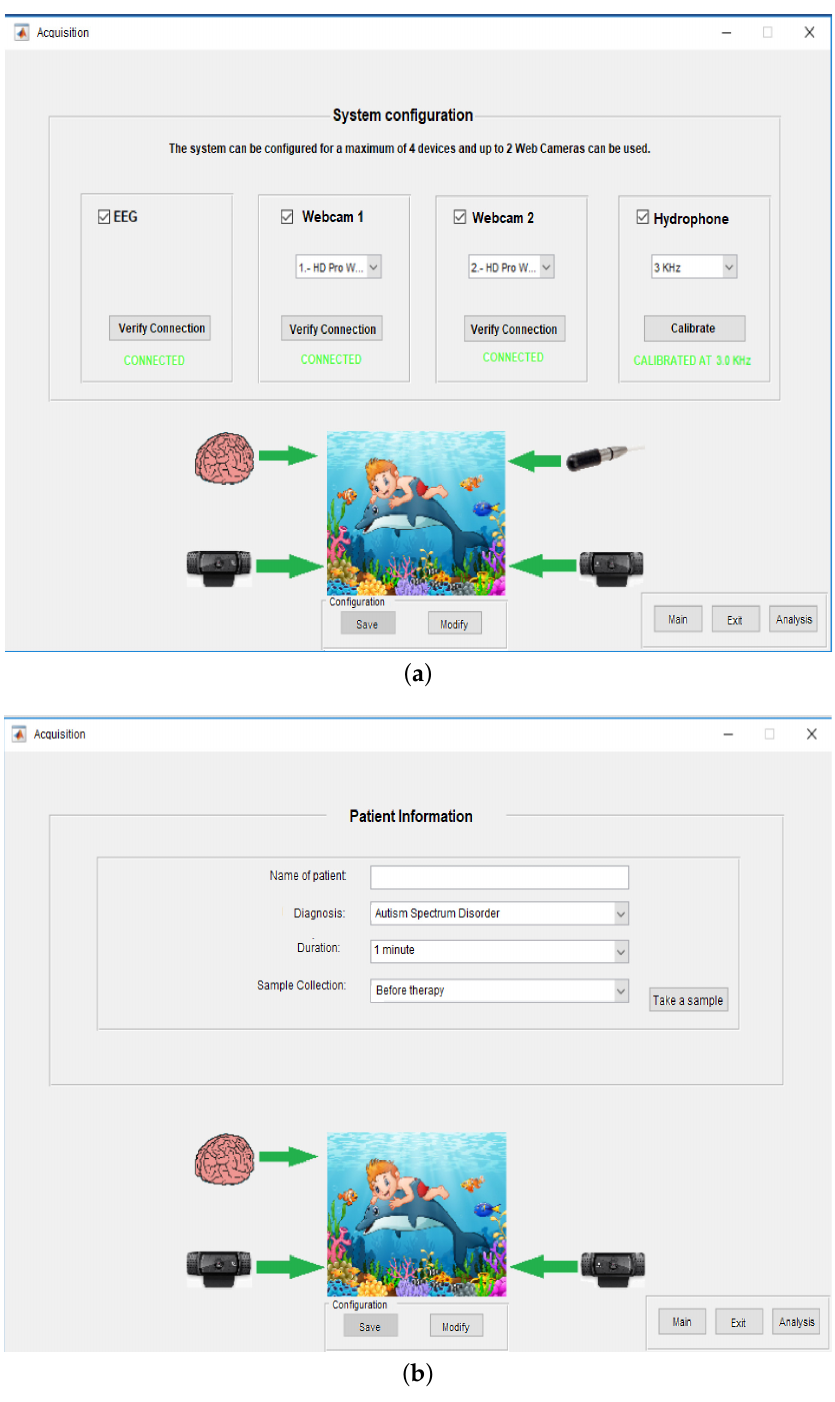
Figure 18. Integrated Development Environment: System for monitoring biomedical signals using parallel-computing IDE. ( a ) Windows of System Configuration and ( b ) Window of Patient